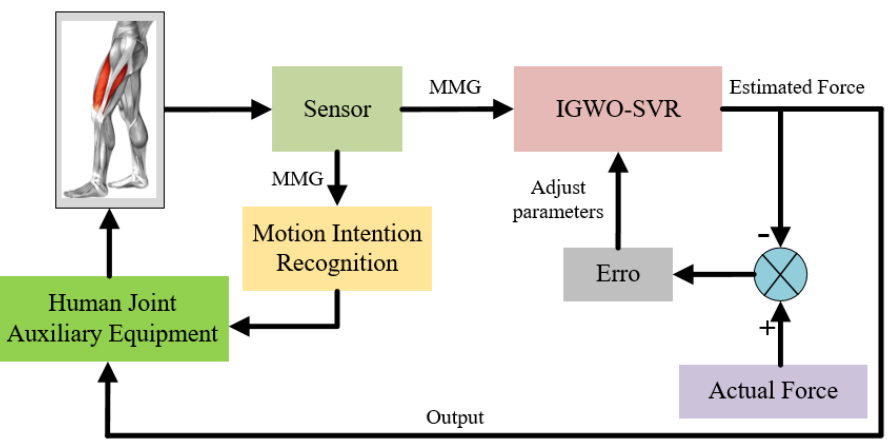
Figure 8. The application example of IGWO-SVR in human joint auxiliary equipment. Based on the recognition of motion intention and the knee joint extension force estimation, they can be used as effective input signals of the human joint auxiliary equipment to realize the compliant control of lower limb movement.